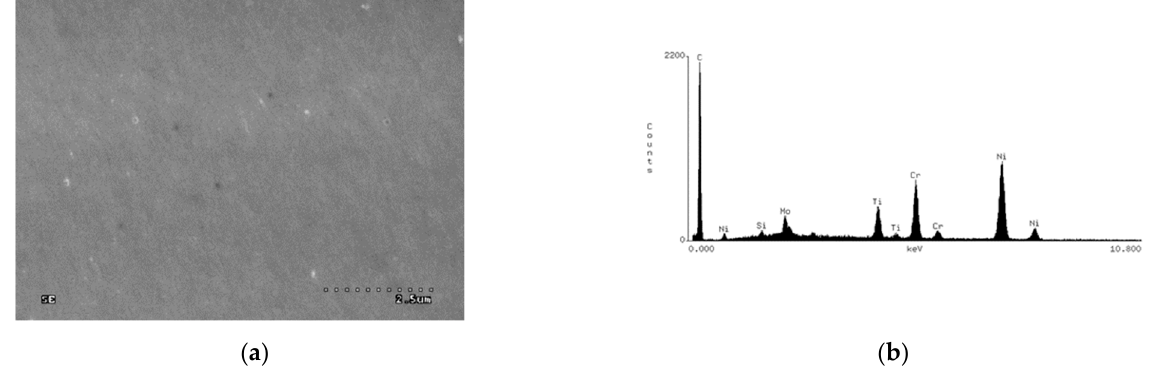
Figure 1. Surface of a sample with a carbon coating ( a ) and an EDS spectrogram from the sample surface ( b ).